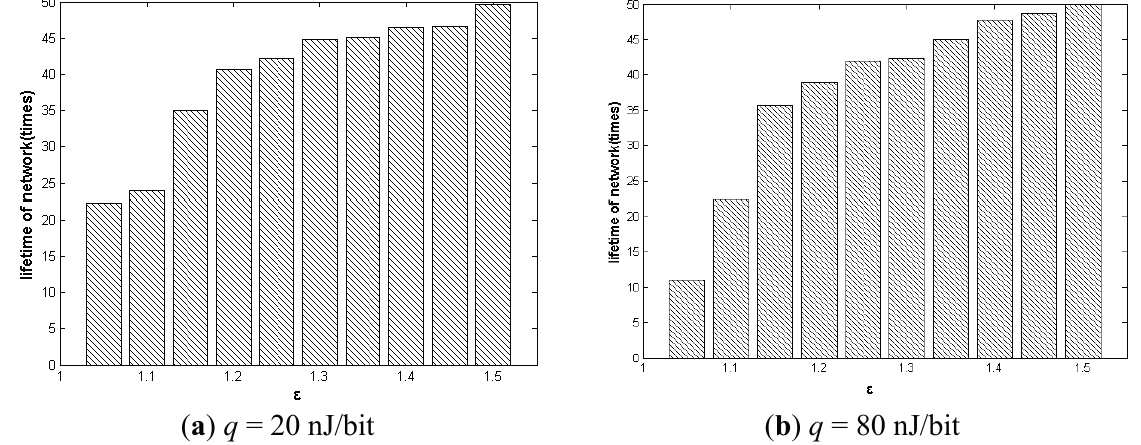
Figure 9. Impact of ε on network